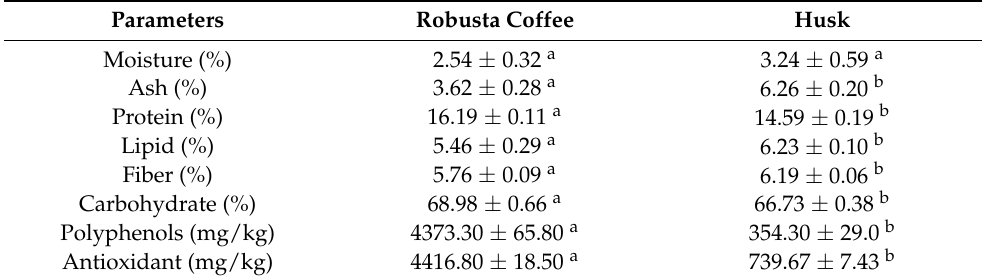
Table 1. Chemical composition of Robusta coffee and husk.